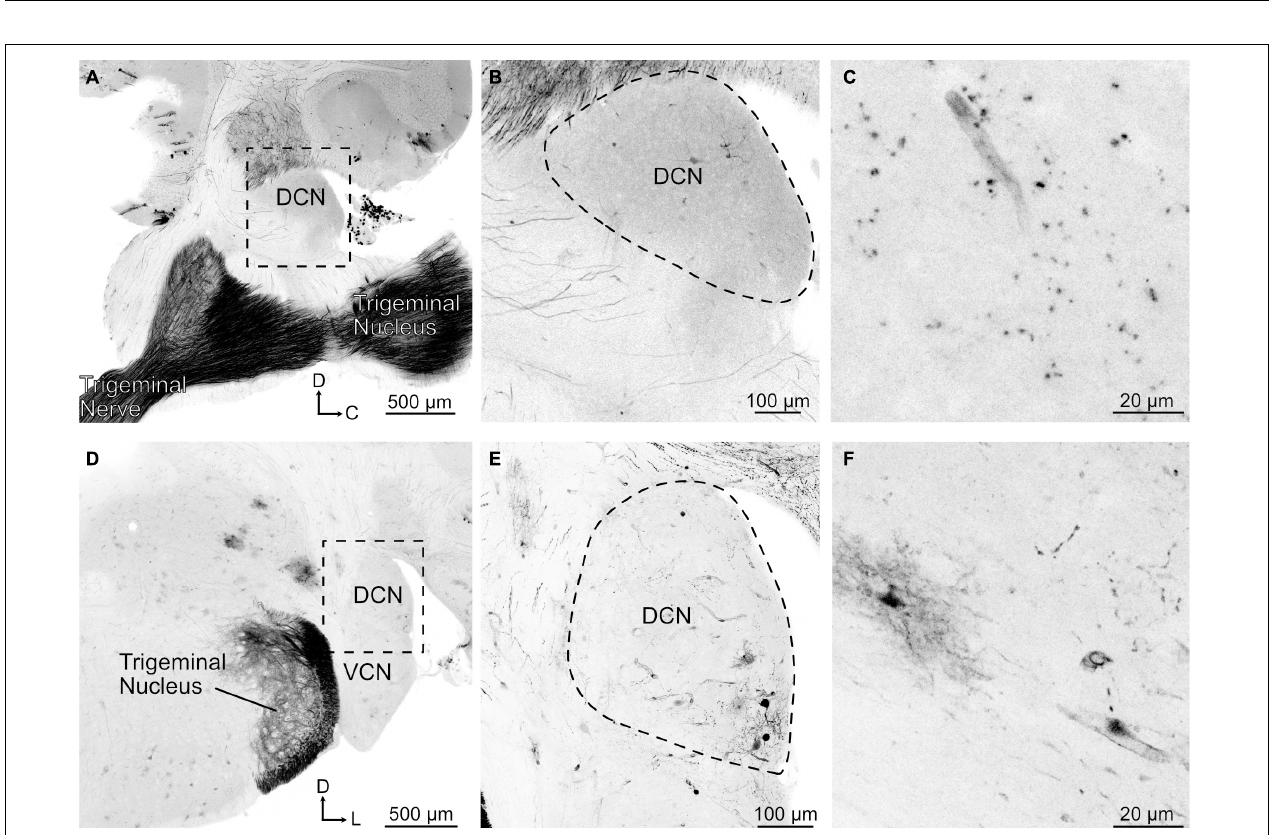
FIGURE 4 | Trigeminal nerve makes few projections to DCN. (A) Sagittal section containing trigeminal nerve, trigeminal nucleus, and DCN. Note that there are few if any labeled axonal fibers that project to DCN despite strong labeling of nerve. tdTomato labeling is shown in black. D, dorsal; C, caudal. (B) Magnified view of the boxed region in A . (C) Higher magnification of a sagittal DCN section showing labeled blood vessel. (D) Coronal section showing trigeminal nerve fibers labeled in the trigeminal nucleus but not in the DCN. VCN, ventral cochlear nucleus; D, dorsal; L, lateral. (E) Magnified view of the boxed region in D showing that the labeled neurons are clustered around a blood vessel. (F) Higher magnification of a coronal DCN section showing a labeled blood vessel, glial cell, and few neuronal processes.